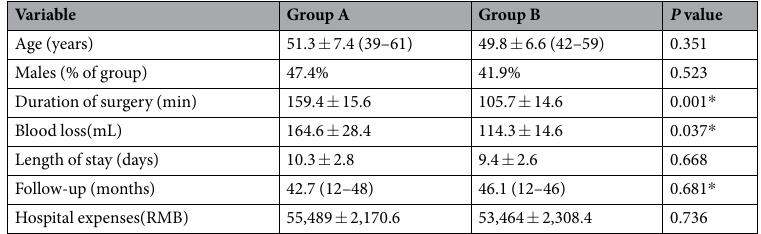
Table 2. Patient demographics and surgical data. * P < 0.05 compared to the data of Group A.